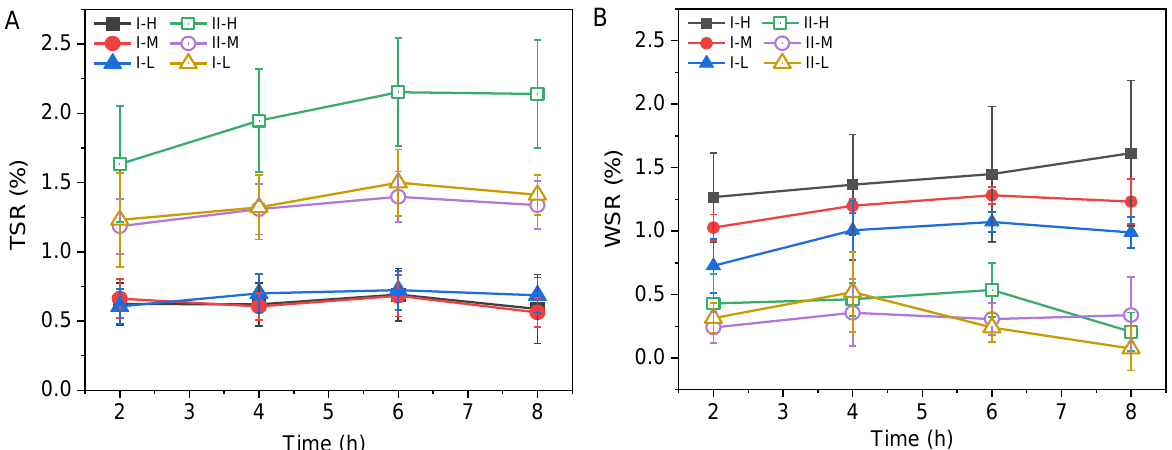
Figure 7. Water resistance of bamboo laminated composites (BLCs). ( A ), the TSR of BLCs; ( B ), the WSR of BLCs. Type I represents parallel laminated BLC, and type II represents cross laminated BLC. H, M, and L represent high, medium, and low fiber volumes, respectively.